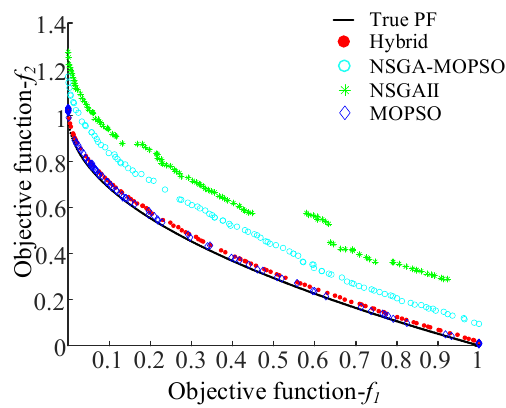
Figure 3. Comparison results for ZDT1.